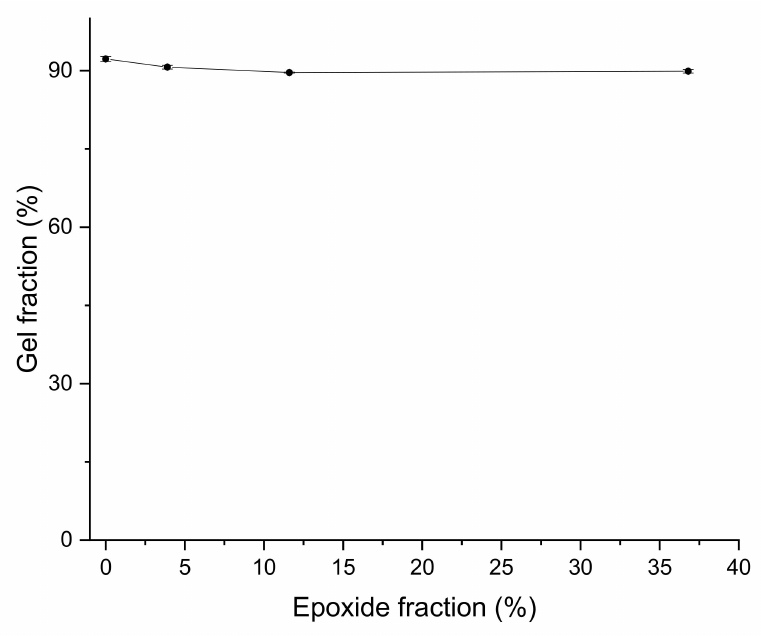
Figure 5. Gel fraction of guayule natural rubber/epoxidized guayule natural rubber blend composites at various epoxide fractions.